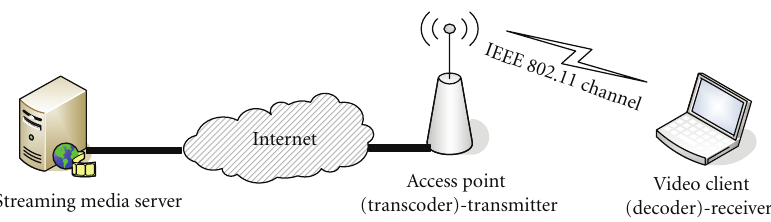
Figure 2: Infrastructure mode IEEE 802.11 wireless network for video